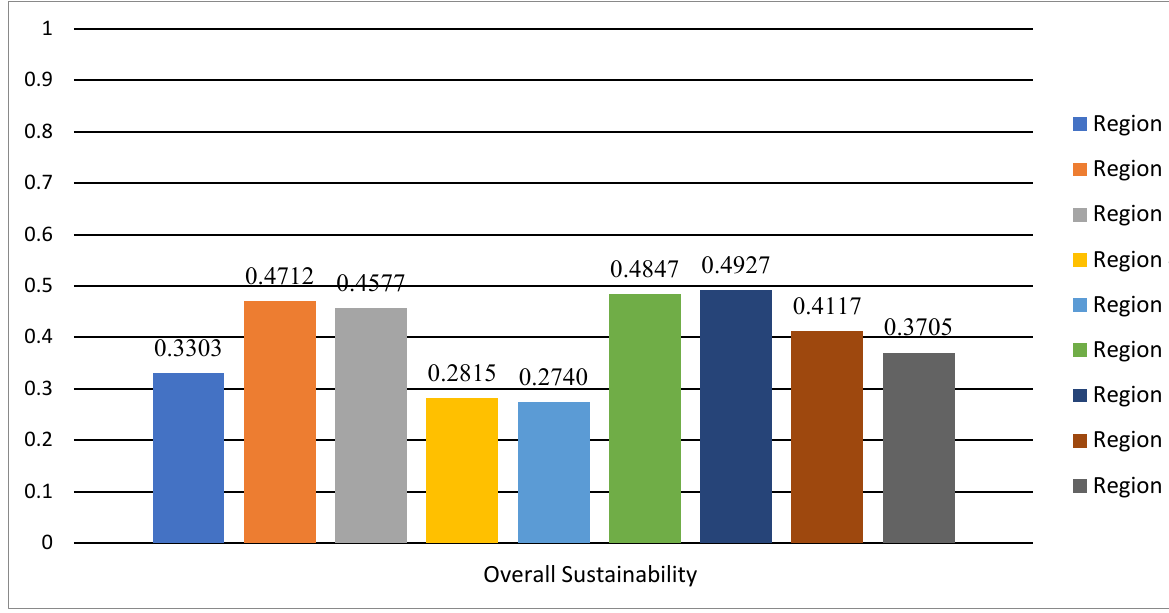
Figure 12. The overall sustainability of the 9 regions.